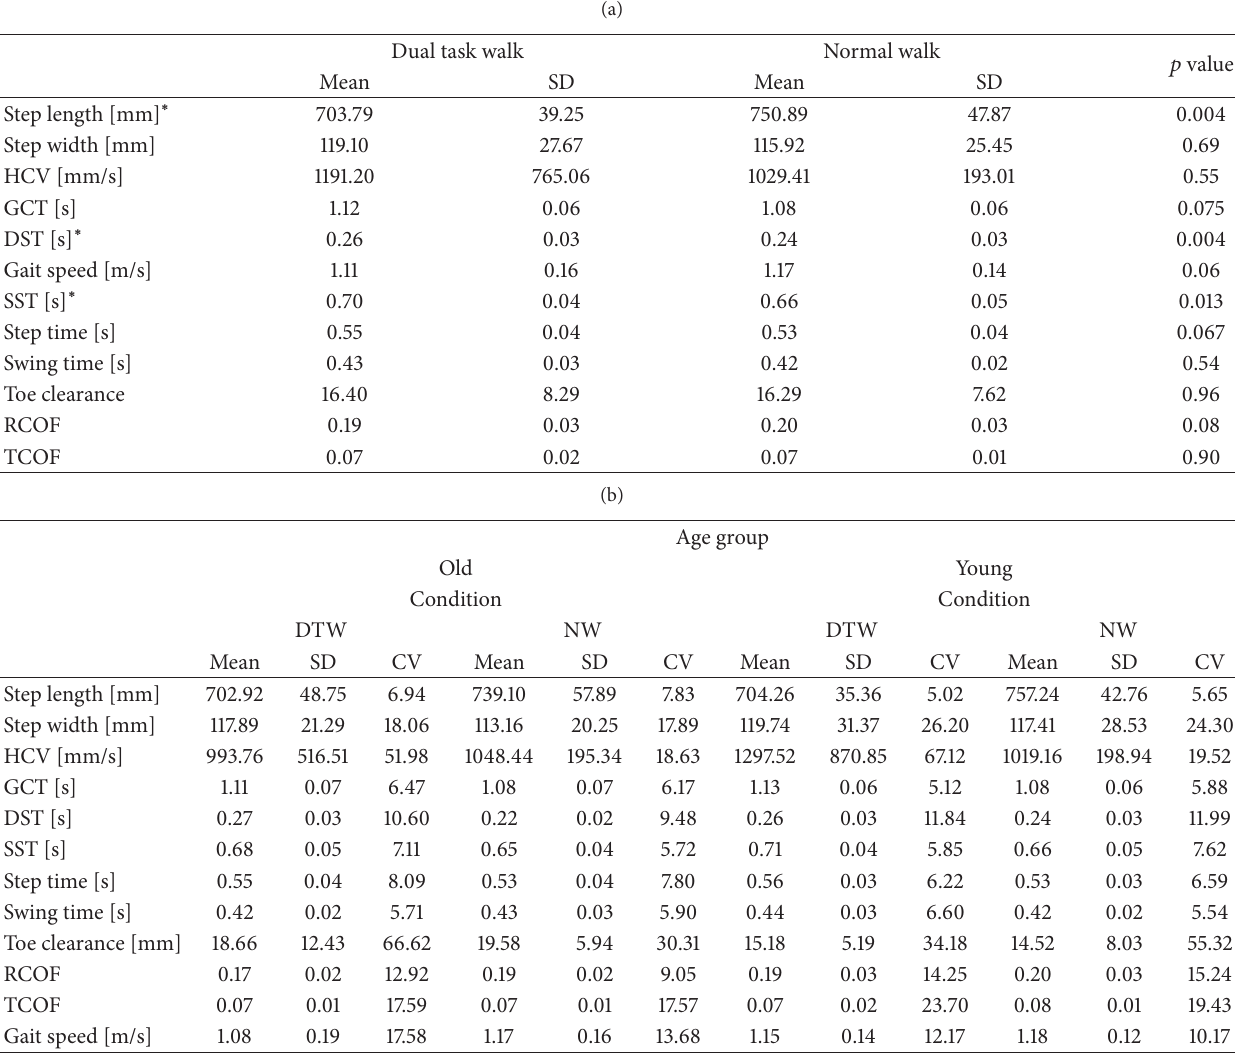
Table 2: (a) Dual-task changes in gait parameters. (b) General gait parameters for younger and older population for normal and dual-tasking types of